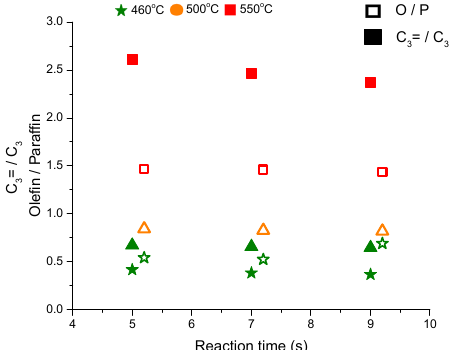
Figure 3. Average C 3 = / C 3 and Olefin / Paraffin (O/P) ratios, calculated from three injections with 95% confidence of ±0.03, as a function of temperature 460–550 °C and reaction time 5–9 s. O/P presented in the figure with white fill, shifted to the right for better clarity. The C 3 = / C 3 is represented by filled shape. The data is obtained from the riser simulator.